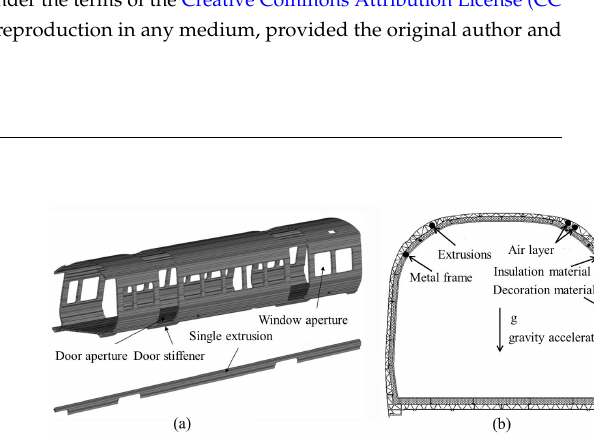
Fig. 1. High speed train body assembles: (a) a typical car body aluminum extrusion assembles; (b) a typical cross section of the train body